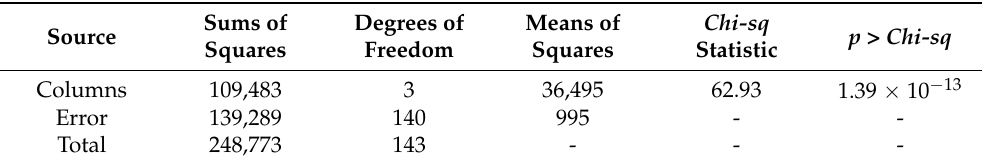
Table 9. Results of Kruskal–Wallis test for oil Midel 1204 with different concentrations of surfactant ROKwino l80.